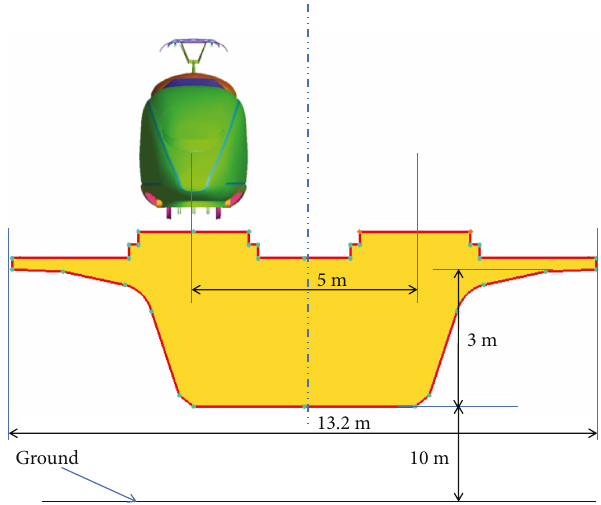
Figure 2: Diagram of horizontal cross section during the passing of high-speed railways on